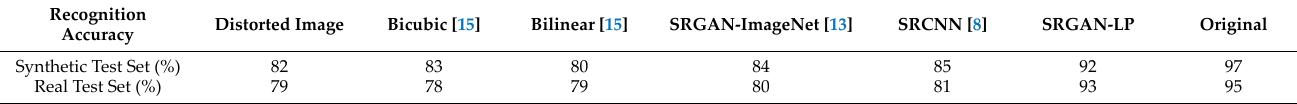
Table 4. Average accuracy calculated for synthetic test set and real test